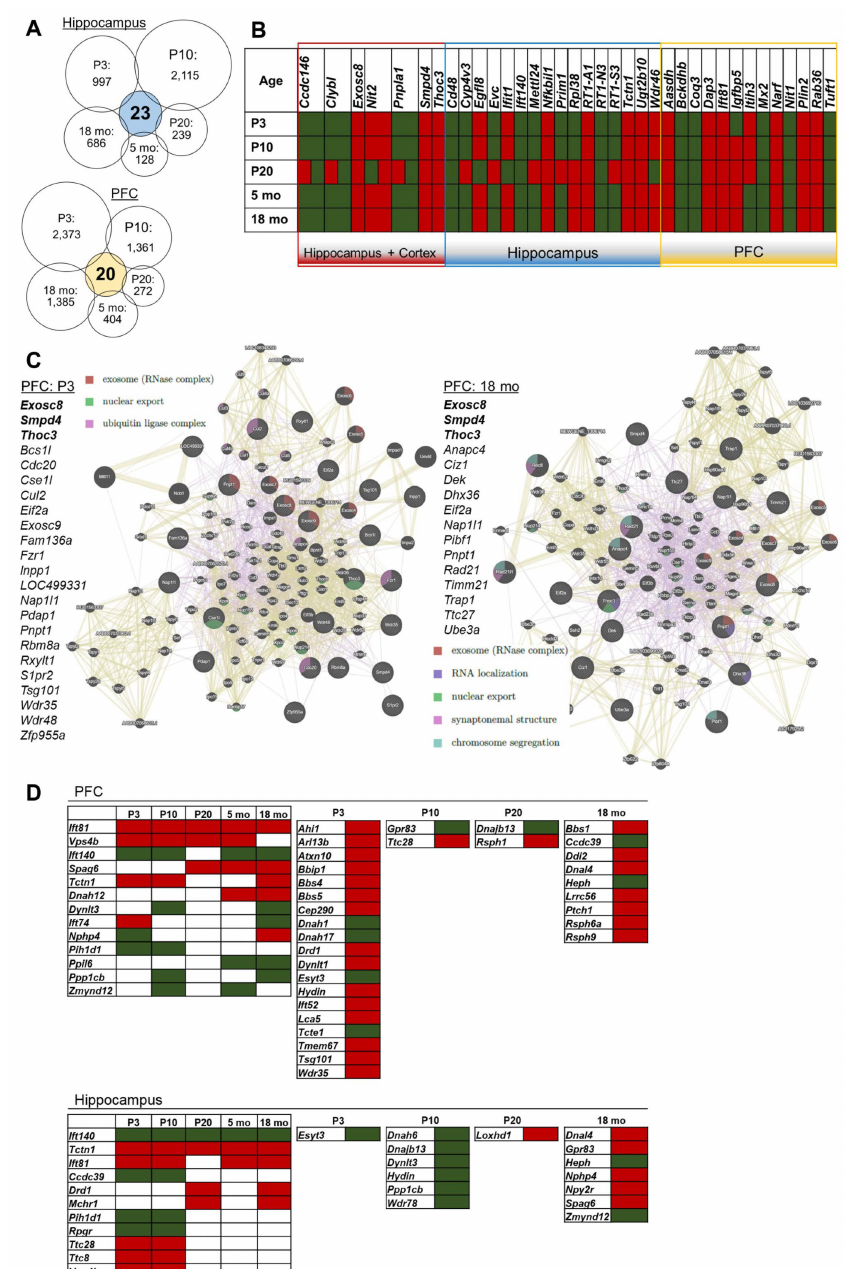
Figure 7. Comparative gene expression analysis in the PFC and hippocampus of OXYS rats at ages P3, P10, P20, 5 months, and 18 months. ( A ) The numbers of DEGs common among ages P3 to 18 months in the PFC and hippocampus of OXYS rats. ( B ) The matching genes that significantly changed expression in the PFC and hippocampus between ages P3 and 18 months in OXYS rats. The DEGs are red if upregulated and green if downregulated. ( C ) In the PFC of OXYS rats at P3 and 18 months, DEGs related to Smpd4 , Thoc3 , and Exosc8 according to GeneMania. ( D ) DEGs related to cilia in the PFC and hippocampus of OXYS rats are marked red if upregulated and green if downregulated. In both brain structures, the expression of three genes changed unidirectionally (was upregulated) throughout the lifespan: Smpd4 , sphingomyelin phosphodiesterase 4; Thoc3 , THO complex 3; and Exosc8 , exosome component 8. The protein encoded by Smpd4 is a sphingomyelinase that catalyzes the hydrolysis of membrane sphingomyelin to produce phosphorylcholine and ceramide. This gene is activated by DNA damage, cellular stress, and tumor necrosis factor [33]. The Thoc3 gene codes for a component of the